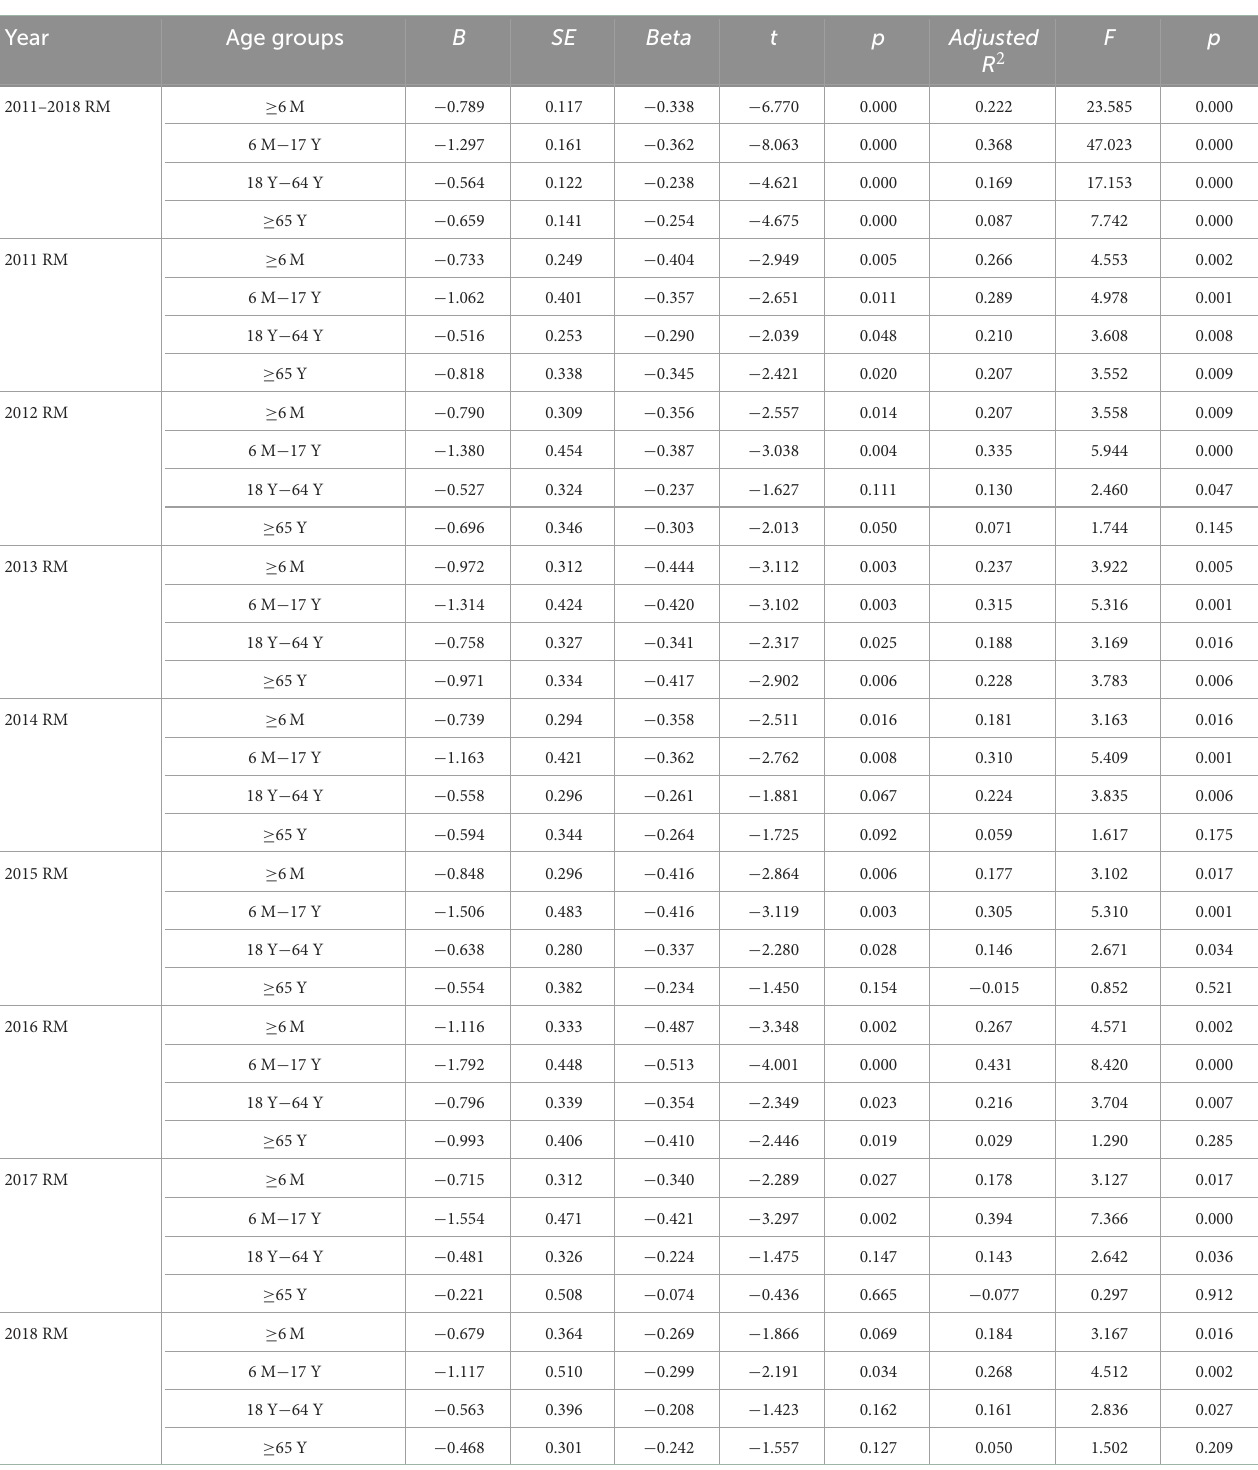
TABLE 6 Regression analyzes of seasonal flu vaccination rates among different age